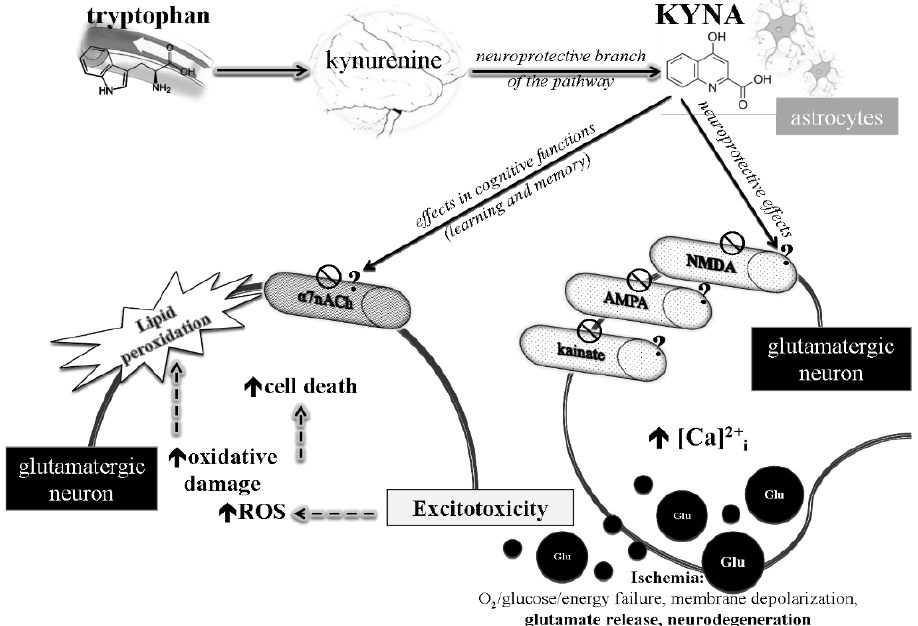
Figure 1. KYNA influences neuronal and glial glutamatergic